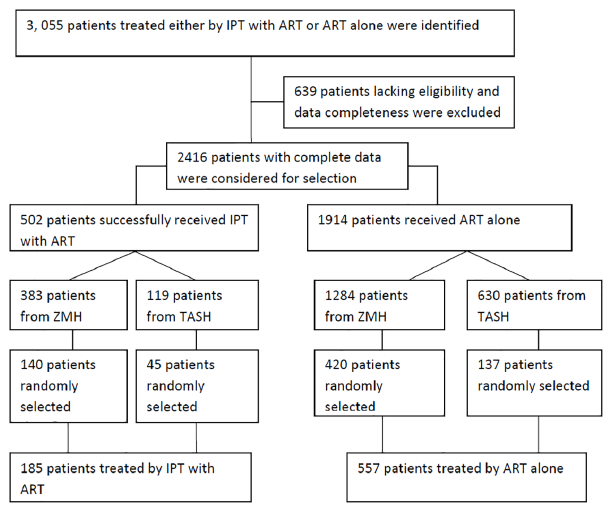
Fig 1. Flow diagram showing selection of study patients on IPT plus ART and ART